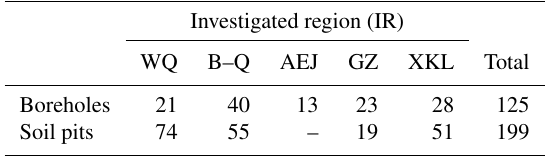
Table 1. Field survey sample statistics in five investigated